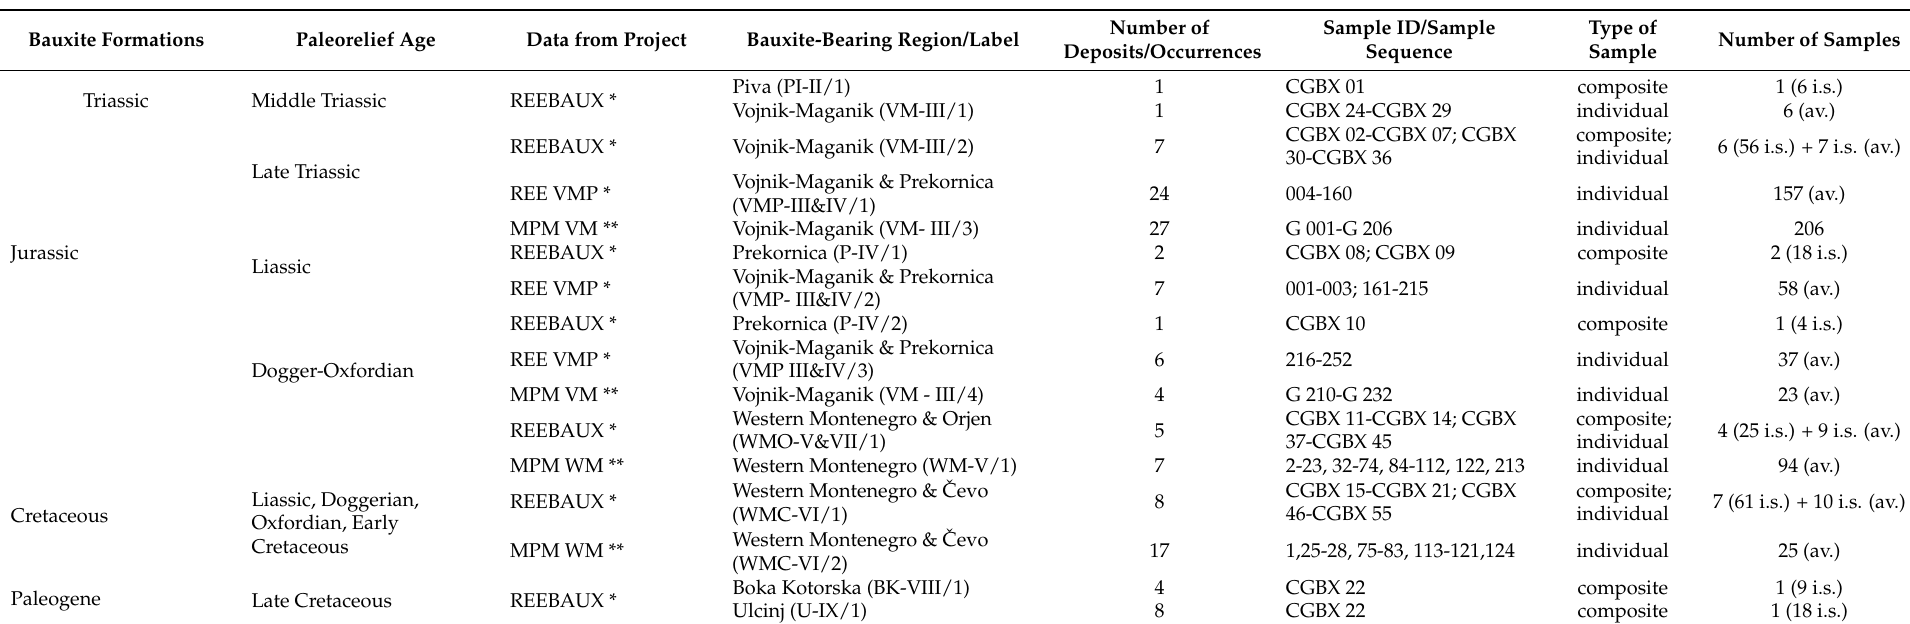
Table 1. Origin and information of bauxite samples from Montenegro (Radusinovi´c [5]; REEBAUX [6]).